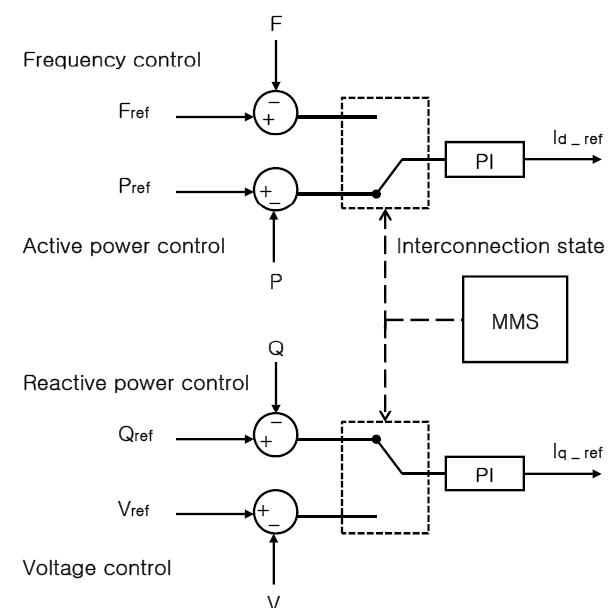
Figure 4. Block diagram of grid controller.